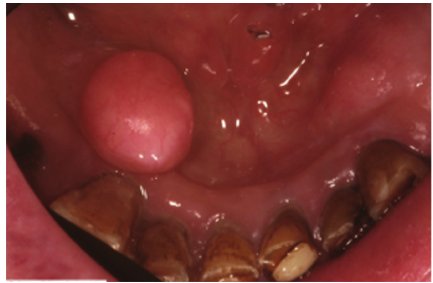
Figure 1: TM. preoperative view.